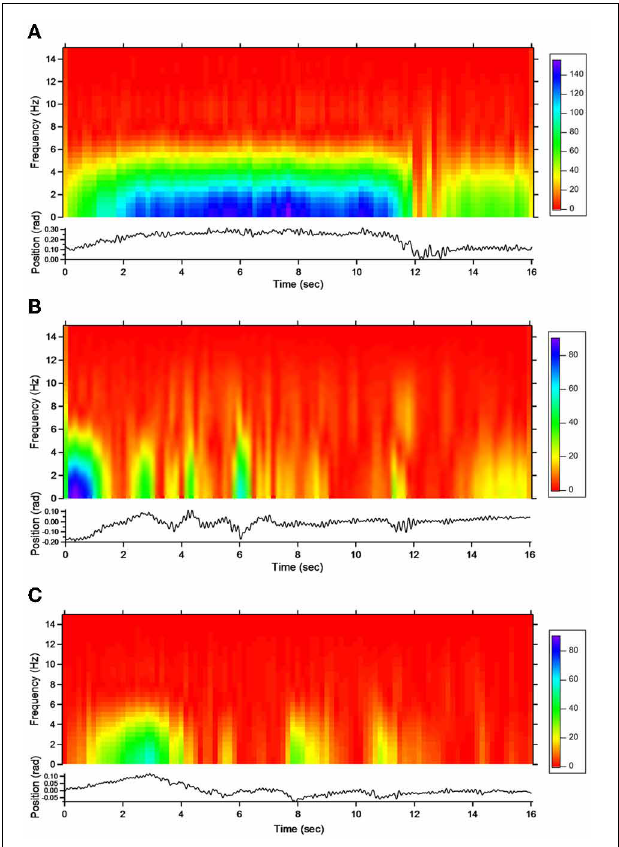
FIGURE 4 | Short-term Fourier transform (STFT) representation of action tremor in patient 1. In each of the 3 panels ( A,B and C ), frequency (in Hz, upper) and position of the manipulandum (in rad, bottom) are illustrated as a function of time. (A) Baseline, (B) post-sham, (C) post-tCCDCS. Note that the color scale of the Y axis is larger in (A) as compared to (B) and (C) .